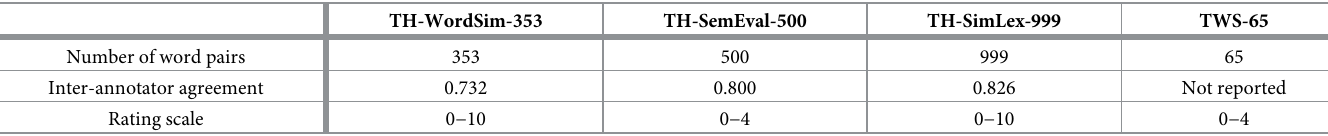
Table 1. Overview of Thai semantic similarity datasets, including number of word pairs, human inter-annotator agreement, and rating